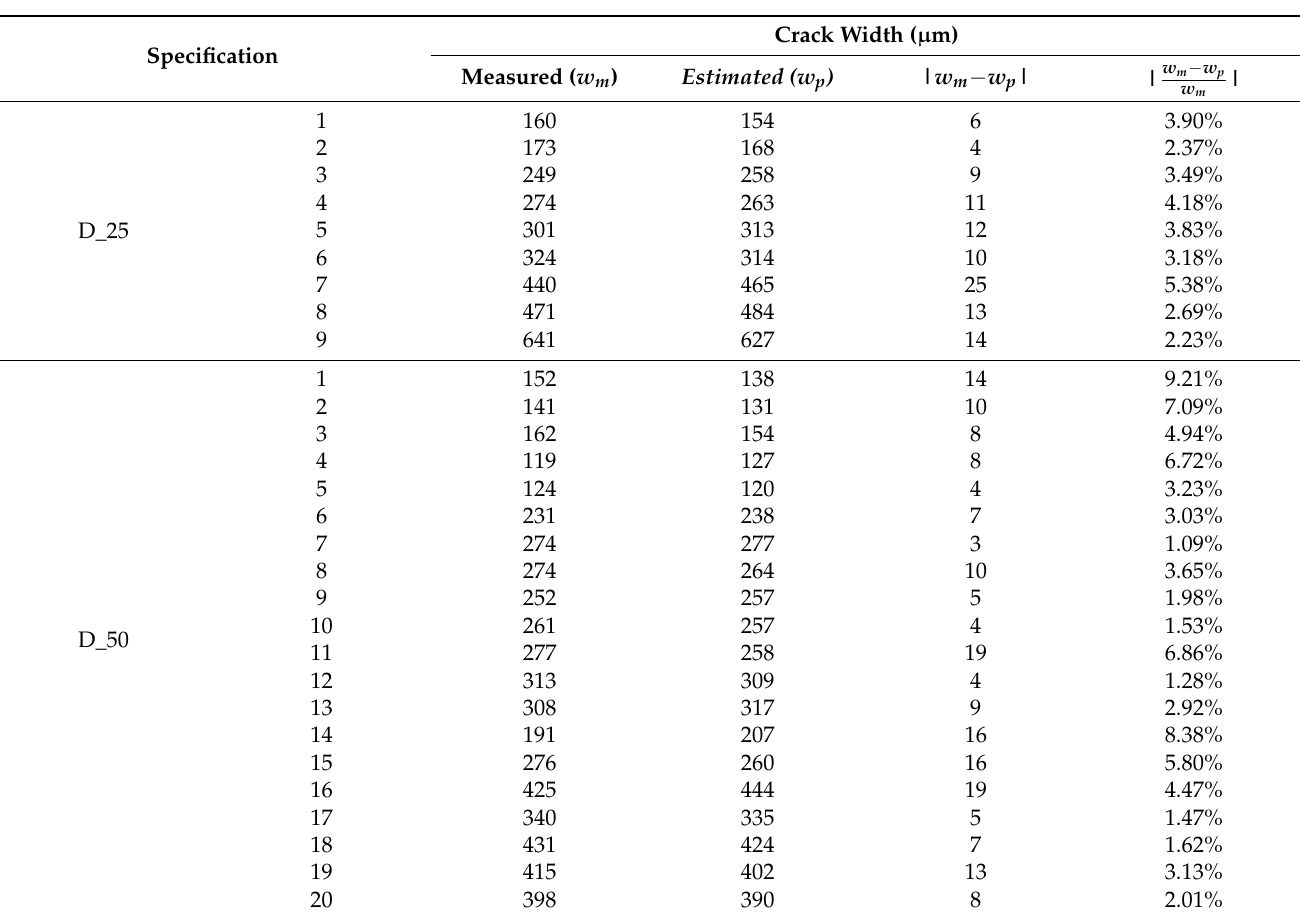
Table 2. Comparison of the measured and estimated crack